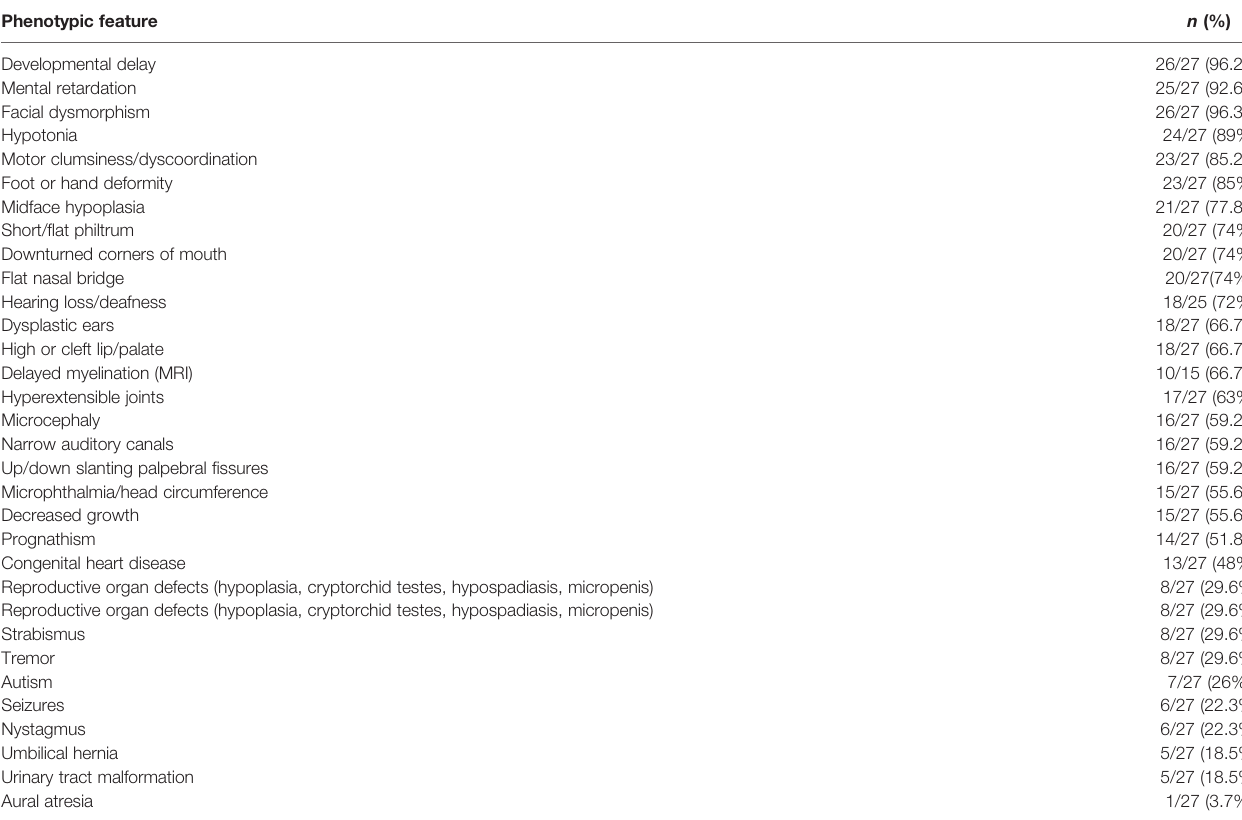
TABLE 3 | Phenotypic features of 27 patients with 18q